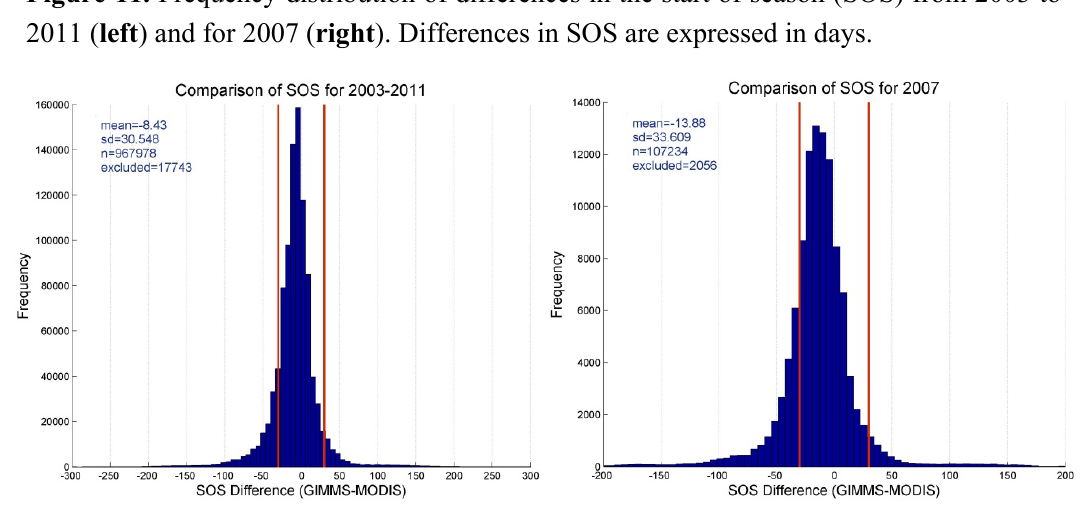
Figure 12. Spatial distribution of start of season (SOS) for GIMMS and MODIS time series.